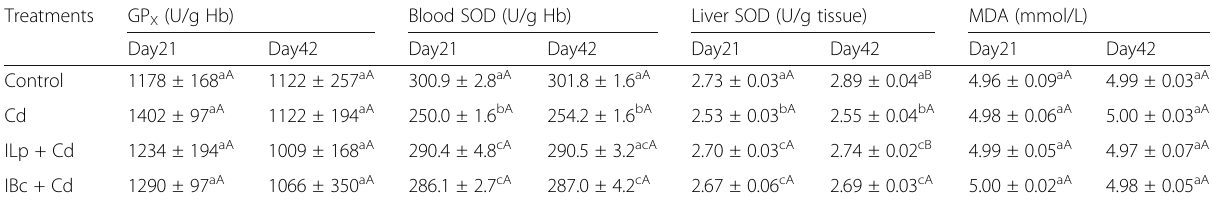
Cd cadmium, ILp + Cd inulin, Lactobacillus plantarum and cadmium, IBc + Cd , inulin, Bacillus coagulans and cadmium. Values are expressed as mean ± SD. The different small letters indicate statistically significant differences in columns ( P < 0.05). The different capital letters indicate statistically significant